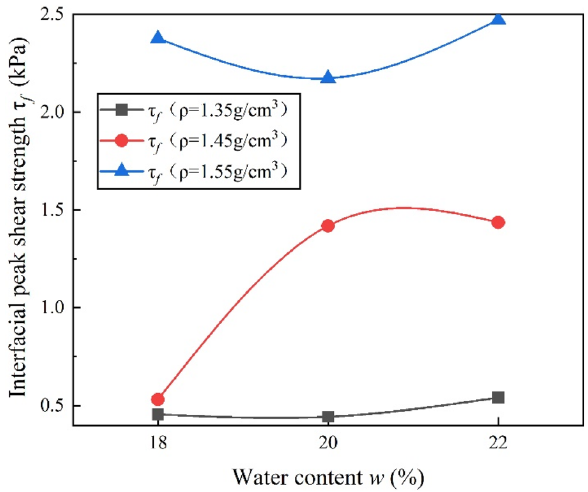
Figure 10. Variation of interfacial peak shear strength for BF reinforced samples compacted at different water contents and